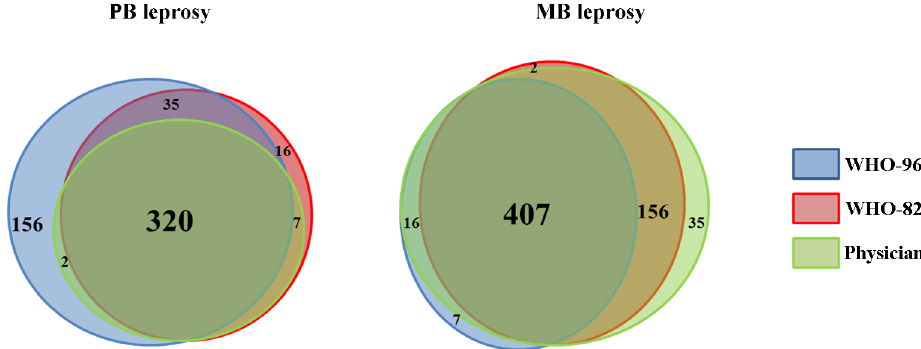
Fig 1. Concordance of leprosy polarization phenotypes according to WHO-82, WHO-96, or physician definitions in a Vietnamese sample. Venn diagram for the number of patients with PB leprosy (left) and MB leprosy (right) according to three definitions: WHO-82, WHO-96, and physician in a Vietnamese sample. The surfaces of overlap are approximately proportional to the number of individuals identically classified by one, two, or three definitions. There was no individual classified PB by a physician and MB by WHO-82 + WHO-96 as well as no individual classified MB by a physician and PB by WHO-82 + WHO-96.